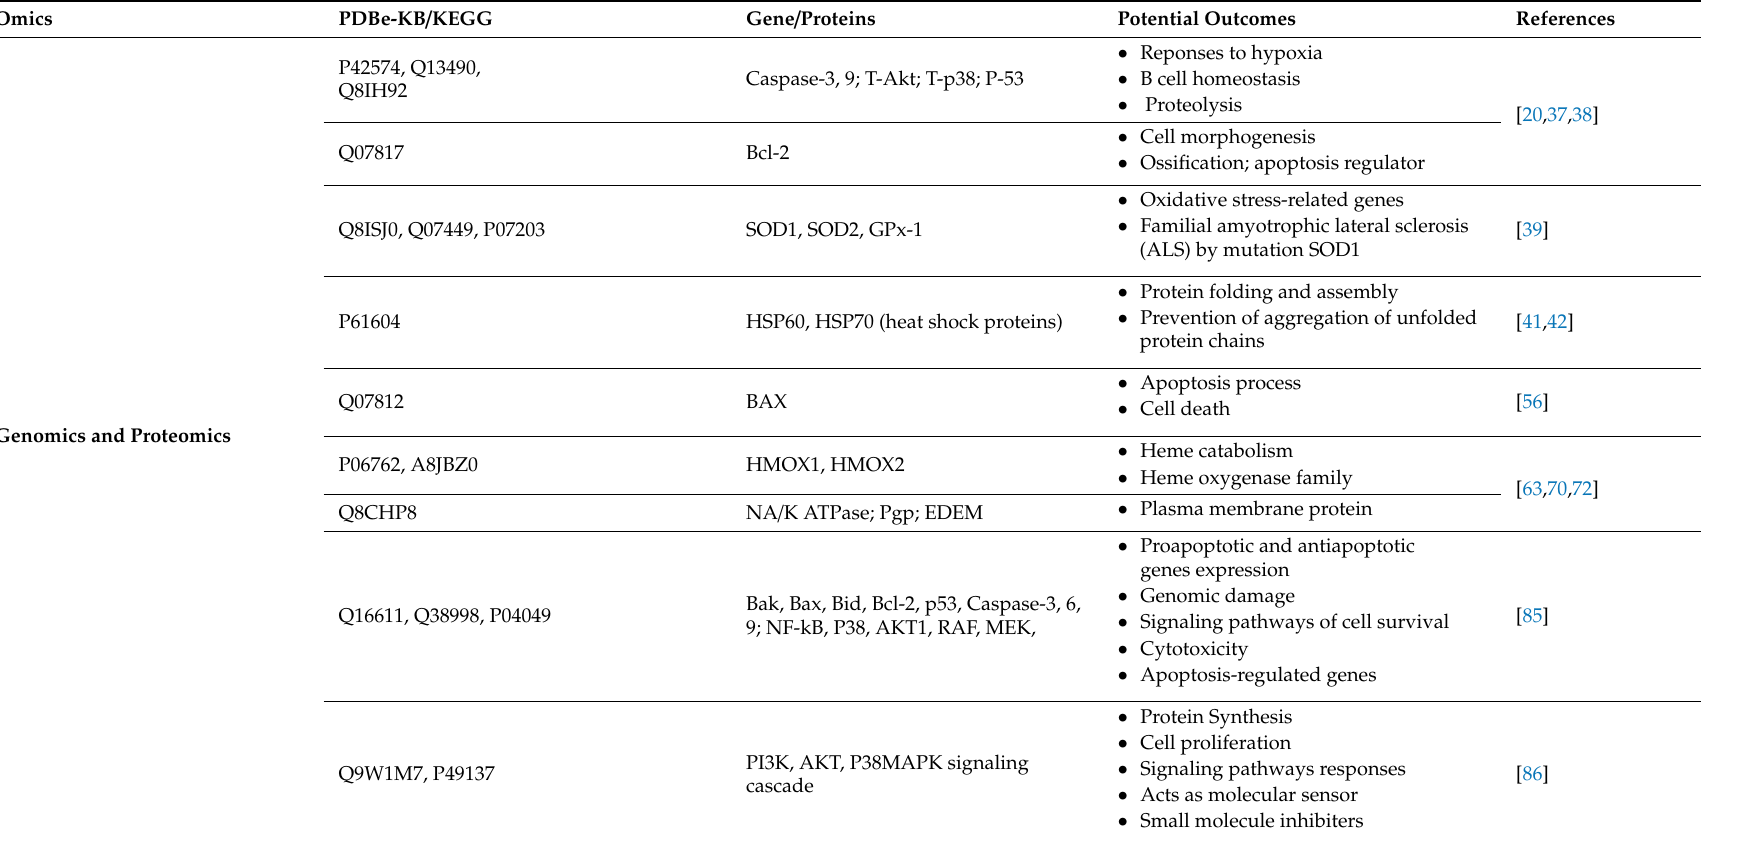
Table 2. In cancer microenvironment, targeted therapeutic biomarkers (genome and metabolome) in di ff erent cancer cells upon exposure to di ff erent sizes of AgNPs in in vitro